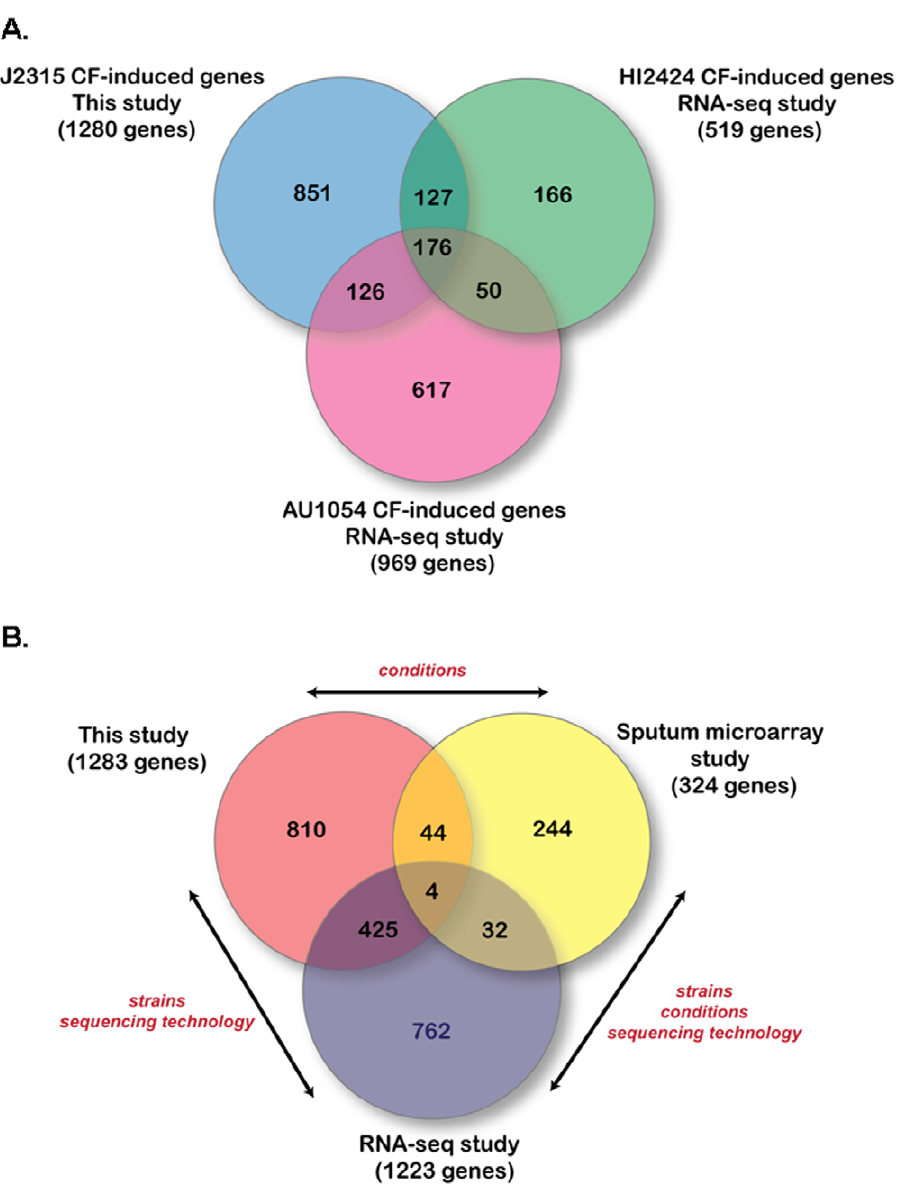
Figure 6. Comparison of microarray data to previous studies. (A) Genes showing at least a 2-fold ratio under CF-like conditions for all three B. cenocepacia strains used in this and a previous RNA-seq study [29] compared to minimal growth conditions (i.e. SE conditions at either 22 or 37 u C). (B) Genes induced in B. cenocepacia strains under CF-like conditions in RNA-seq study [29] and microarray study using different media [29,30] were collected and compared to the microarray data from this study. The experimental differences between the studies are shown in red text. Note that intergenic regions and genes not found in J2315 were removed from analysis.